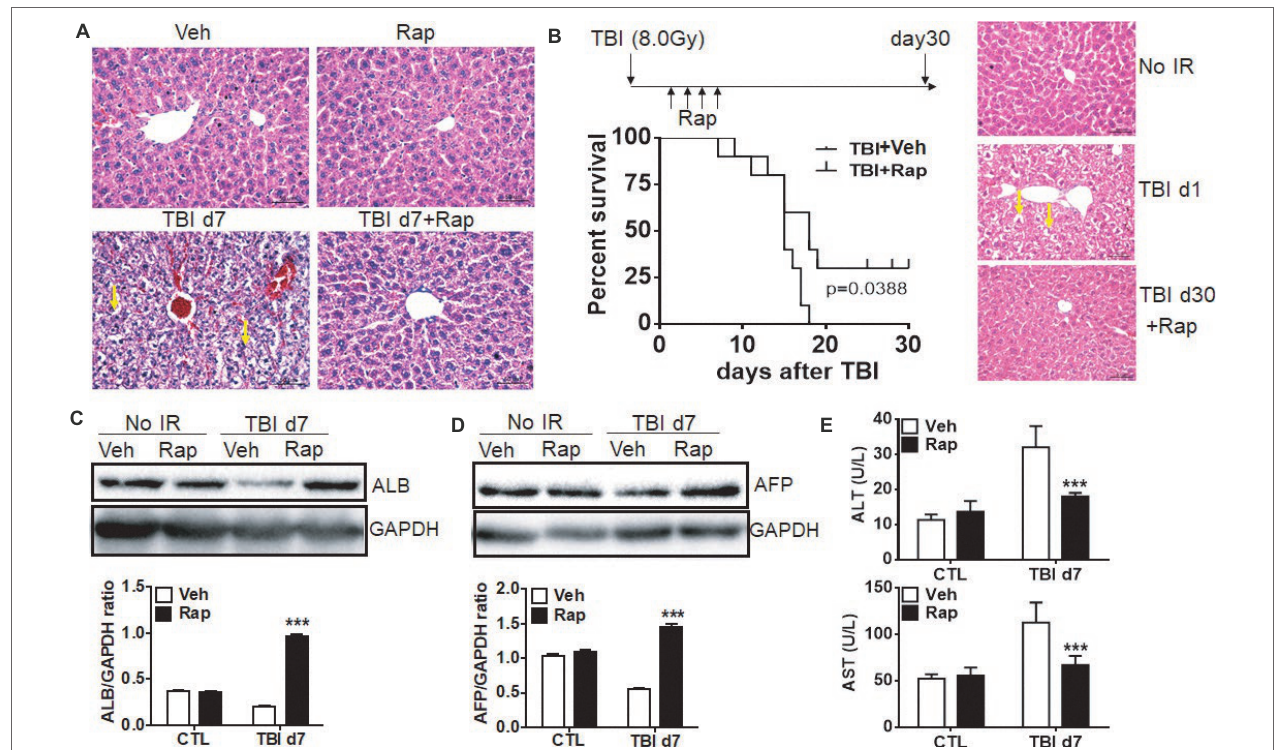
FIGURE 5 | Rapamycin treatment attenuated the liver functional defect induced by irradiation. C57BL/6J mice were treated with vehicle (Veh) or rapamycin (Rap) starting at 6 h after irradiation. Liver tissues were harvested at day 7 post-exposure. (A) Representative pictures by HE staining are shown ( n = 6). Scale bar = 50 μ m. Arrows indicate edema hepatocytes. (B) Kaplan-Meier plot indicating survival of mice with vehicle or rapamycin treatment after irradiation. Irradiated mice were treated with vehicle or rapamycin as above. Mice were monitored daily until day 30 after irradiation ( n = 16). Significance was determined by Mantel-Cox test (left panel, p = 0.0388). HE staining was performed in liver tissues before irradiation and day 1 and 30 after irradiation with rapamycin treatment (right panel). Scale bar = 50 μ m. Arrows indicate edema hepatocytes. (C and D) Expression of ALB and AFP in liver tissues ( n = 3). Expression of ALB (C) and AFP (D) was detected by western blotting at day 7 after irradiation. GAPDH was used as a housekeeping control. Expression of ALB (C) and AFP (D) was quantitated by ImageJ software. The ratios of ALB/GAPDH and AFP/GAPDH were presented. (E) Levels of ALT and AST in serum from different groups ( n = 6). *** p < 0.001 vs.